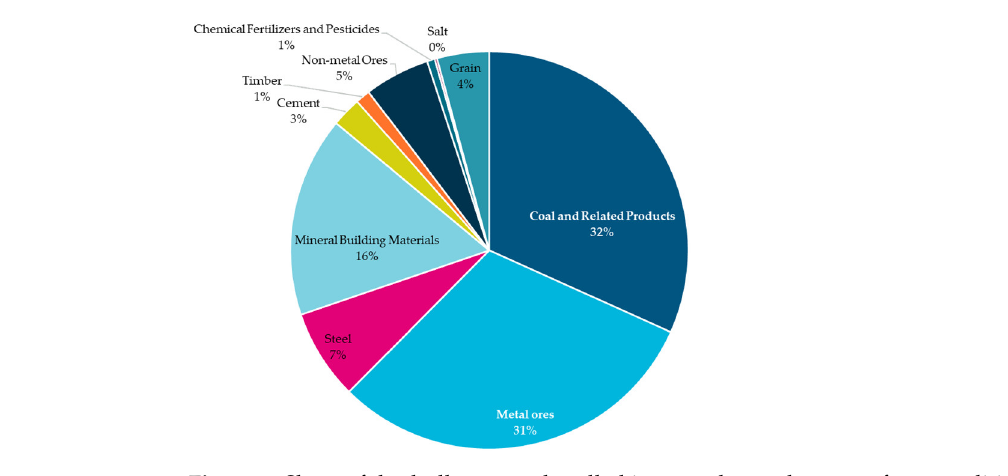
Figure 1. Share of dry bulk cargoes handled in coastal ports by type of commodities (2020). Source: National Bureau of Statistics of China.